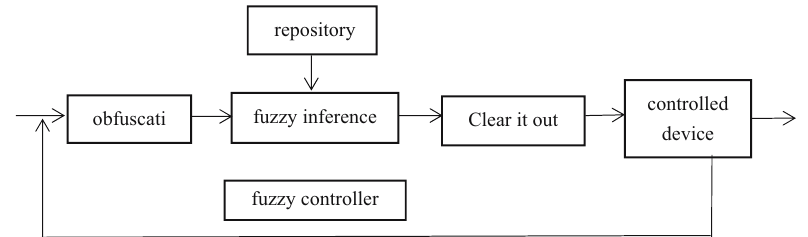
Figure 5: Basic structure of fuzzy controller.